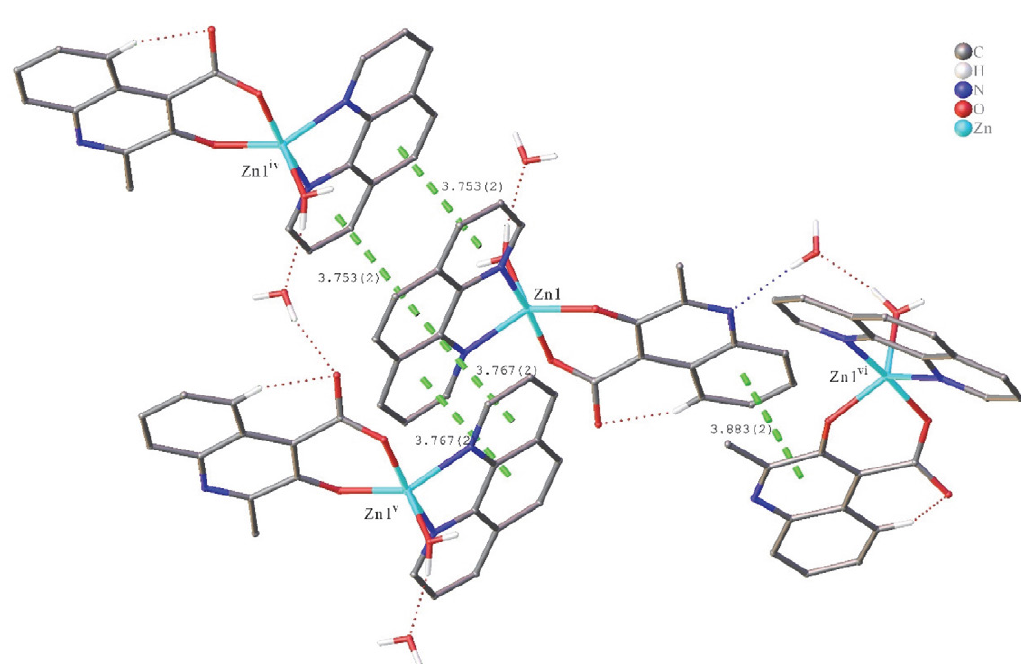
Fig. 4. The π∙∙∙π stacking interactions of the title complex. Symmetric codes (iv): 2 – x , 1 – y , 1 – z ; (v): 1 – x , 1 – y , 1 – z ; (vi): –½ + x , y , ½ –